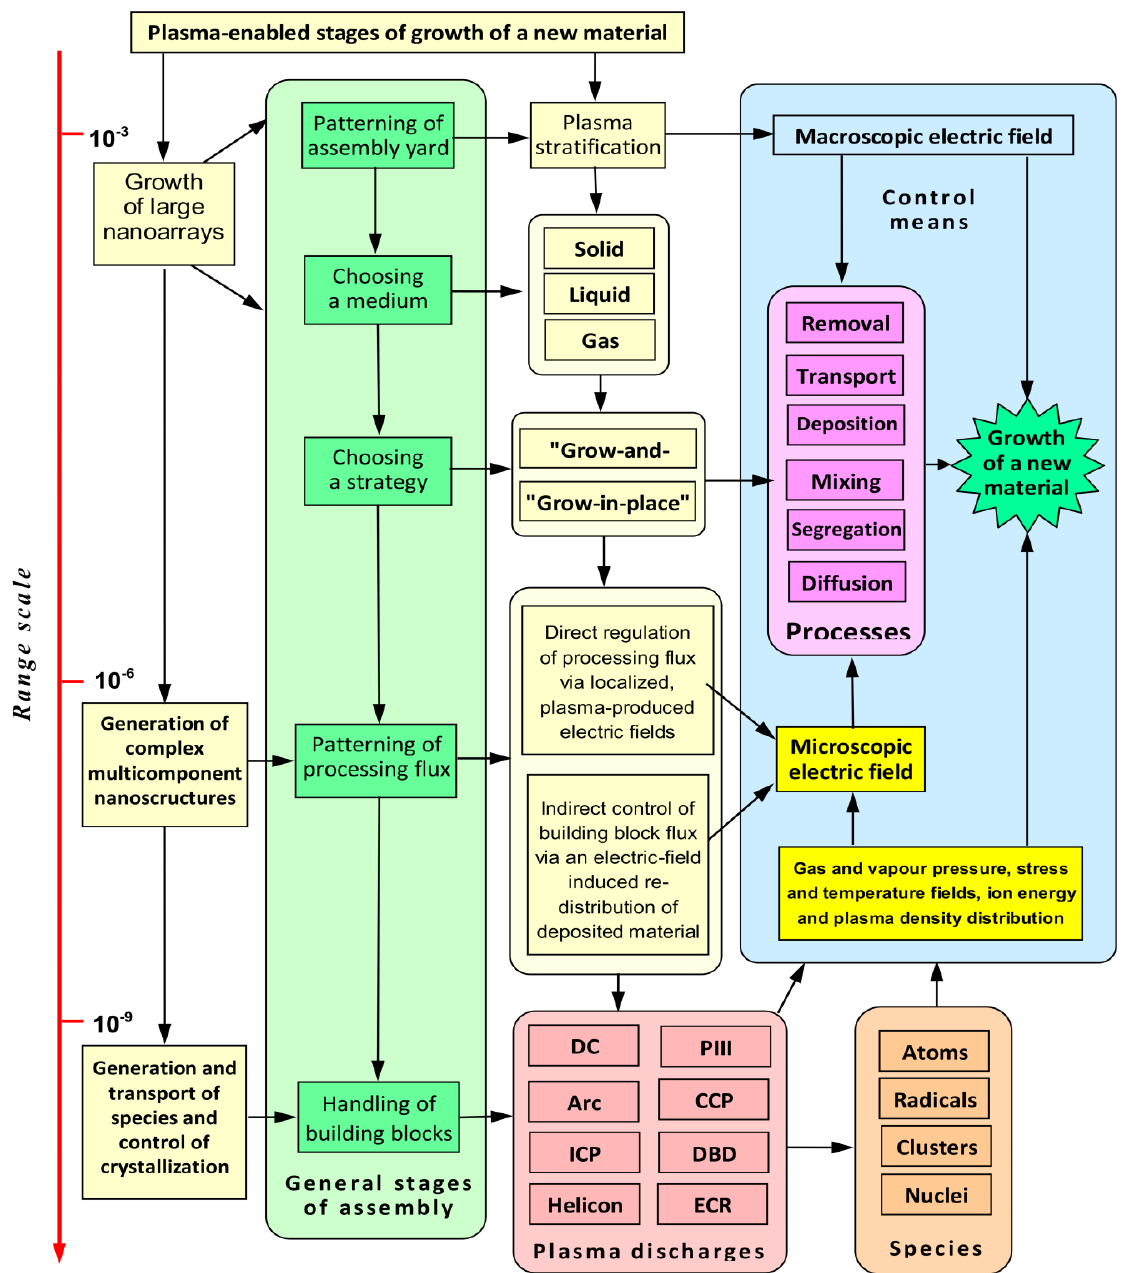
Figure 2. Common control mechanisms in plasma-enhanced processing of matter across multiple length scales, from particle nucleation at nanoscale, to growth of objects and arrays at micrometer and millimeter scales, respectively. Reactor geometry, energy source, and external electric and magnetic fields can be tuned to optimize the process toward specific growth and functionalization outcomes. DC refers to a direct current source, arc refers to arc plasma, ICP and CCP denote inductively and capacitively coupled plasmas, respectively, DBD denotes dielectric barrier discharges, ECR refers to electron cyclotron resonance plasma sources, and PIII refers to plasma immersion ion implantation. Reproduced with permission from Baranov et al. (2018) [34].